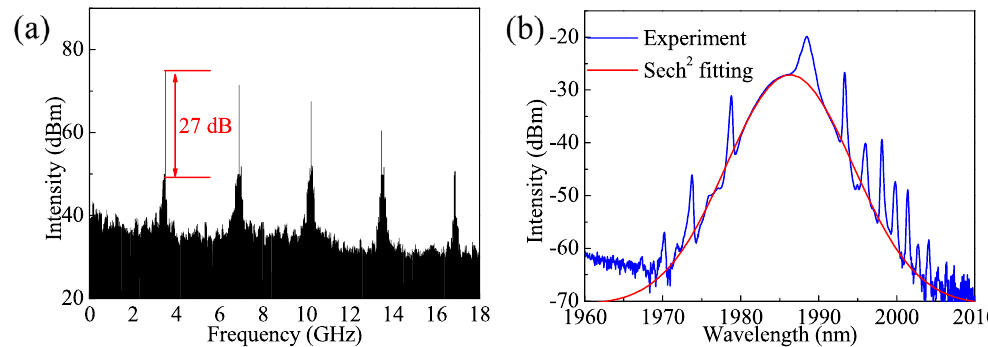
Figure 3. ( a ) RF spectrum of HML at repetition rate of 3.4 GHz with a scanning range of 18 GHz, and ( b ) Optical spectrum corresponds to ( a